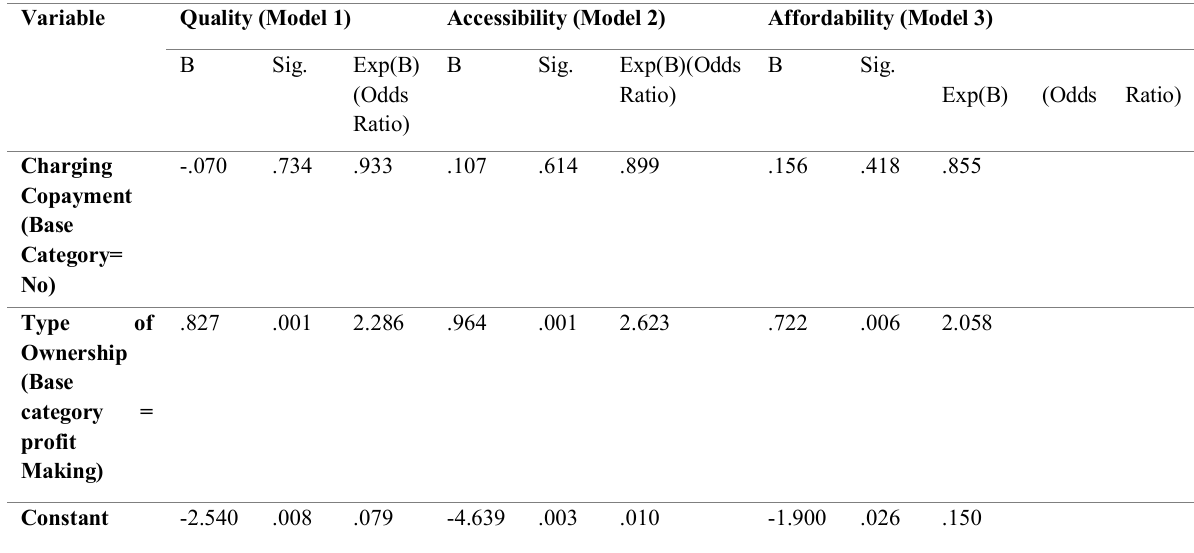
Table 3: Regression Analysis on Effect of Copayment on Effective Health Service